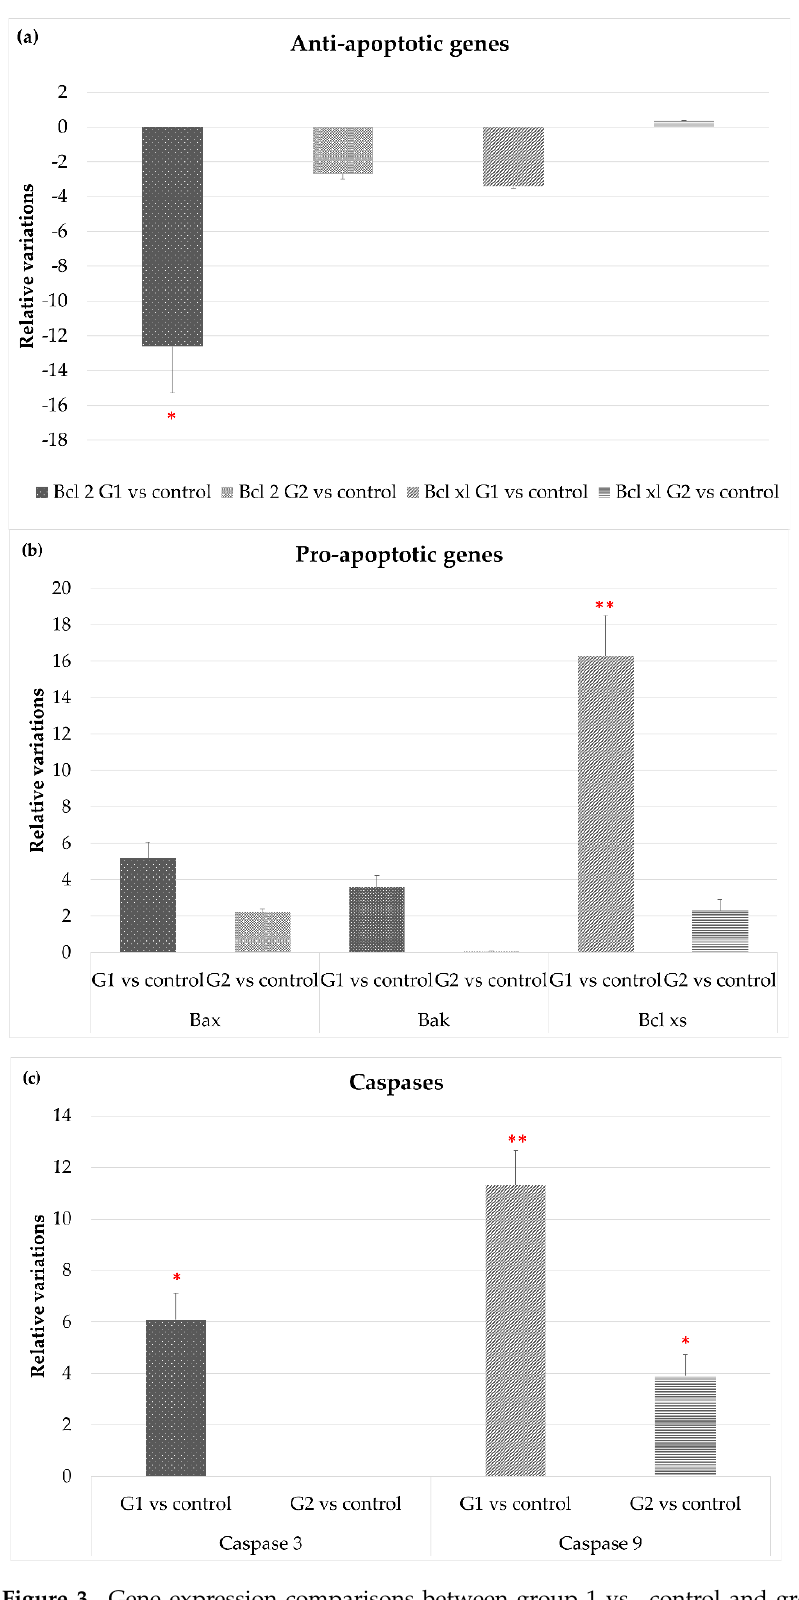
Figure 3. Gene expression comparisons between group 1 vs. control and group 2 vs. control. ( a ) Anti-apoptotic gene ex- pression, ( b ) pro-apoptotic gene expression, and ( c ) gene expression of apoptotic-related enzymes. * p < 0.05; ** p <